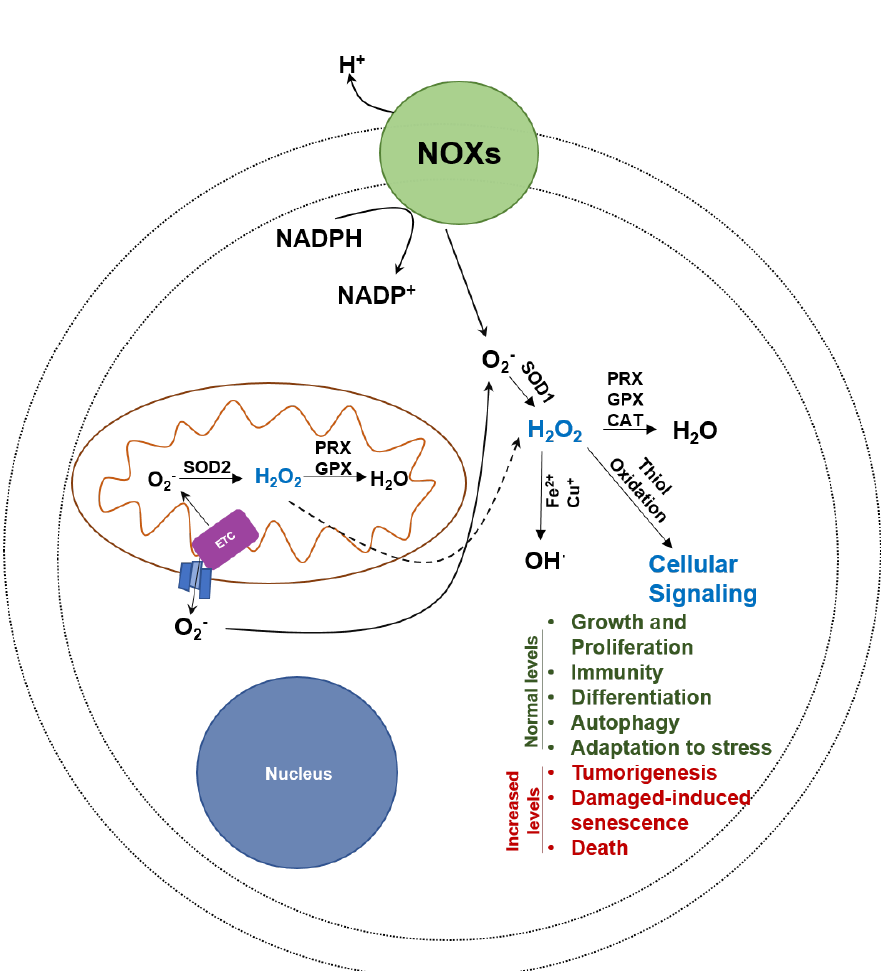
Figure 2. Uncontrolled oxidative stress is cytotoxic to cancer cells. OXPHOS is a major producer of oxygen radicals. While oxygen radicals have positive benefits in cells, a rapid and uncontrolled rise in hydroxyl radicals can lead to cancer cell death. PRX, peroxiredoxin, GPX, glutathione peroxidase, CAT, catalase, SOD, superoxide dismutase, and NOX, NADPH oxidase.